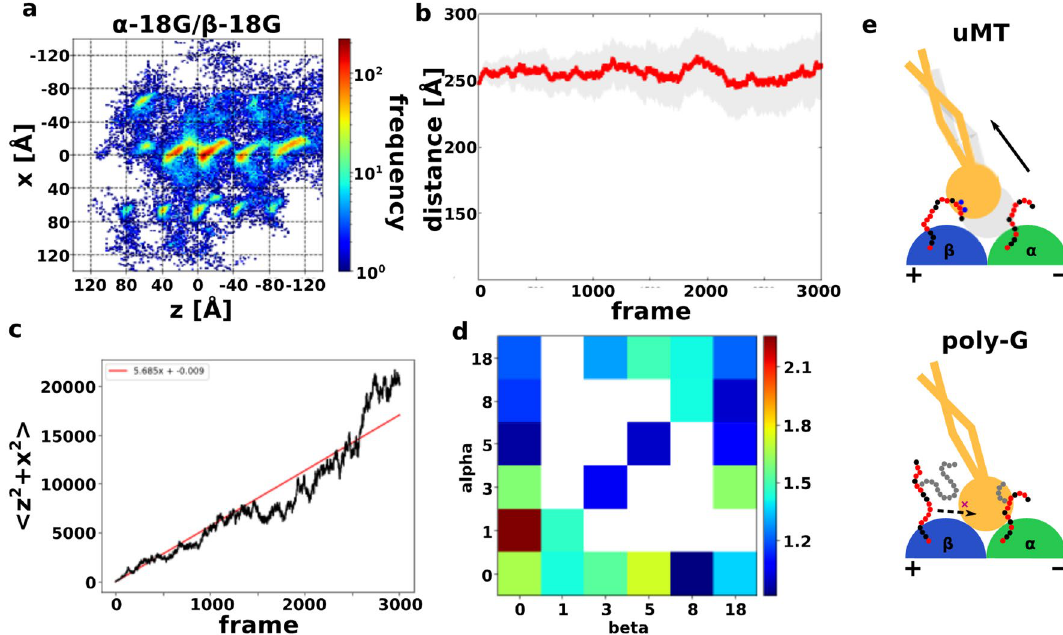
Figure 5. Low-affinity state dynein with poly-G MT. ( a ) Heat map of the position of the low-affinity state MTBD on the poly-G MT, with 20 trajectories overlaid. The coloring method is same with Fig. 1d. This is in the α-18G/β-18G case. ( b ) The trajectory of the average direction between the tip of the linker to the closest tubulins in the α-18G/β-18G case. The coloring method is same with Fig. 4e. ( c ) MSD plot of α-18G/β-18G case (black) and its linear approximation line (red). ( d ) The heatmap of the diffusion coefficient in the various poly-G simulation systems. Blue is small diffusion, red is high diffusion, and the white is not simulated setups. ( e ) Cartoon for understanding poly-G simulation features. When MT does not have poly-G, CTT directly contacts to MTBD, and CTT induces MTBD flexible motion (above). On the other hand, when poly-G MT prevents CTT from contacting MTBD, thus suppressing the diffusion of